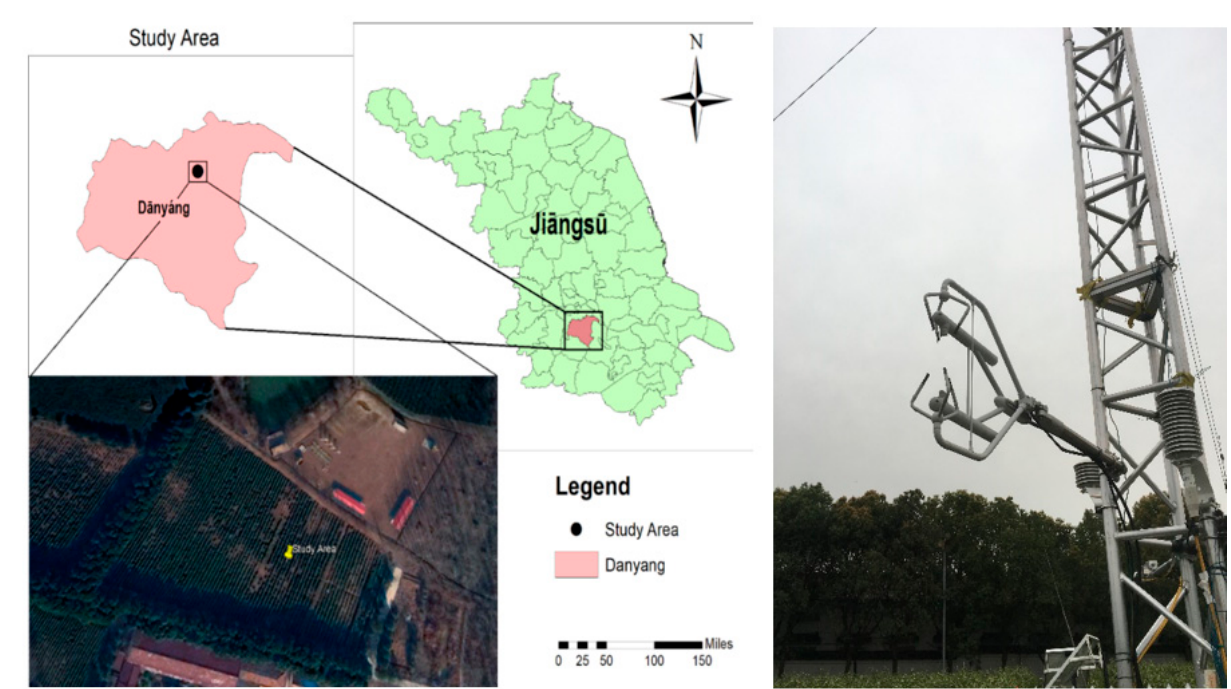
Figure 1. A map representing the location of the study area and the eddy covariance (EC) system installed at study site. All pieces of equipment were supported with batteries connected with solar panels.